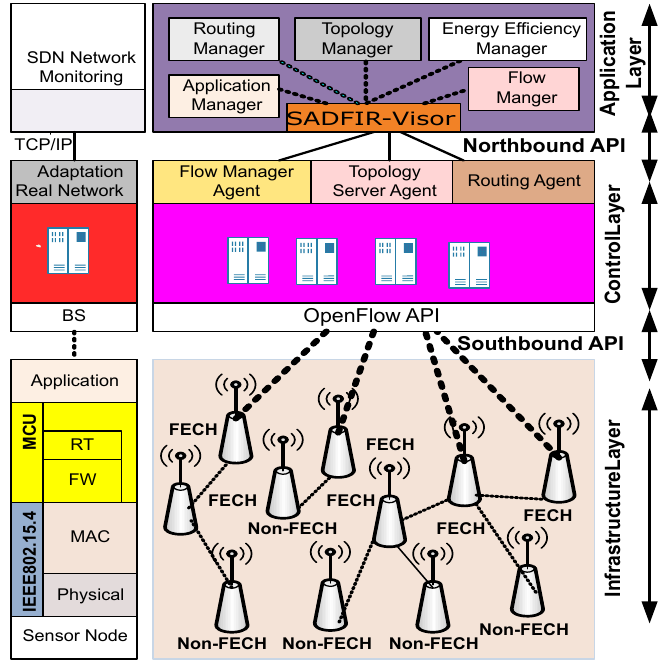
Figure 2. Hybrid architecture of heterogeneous